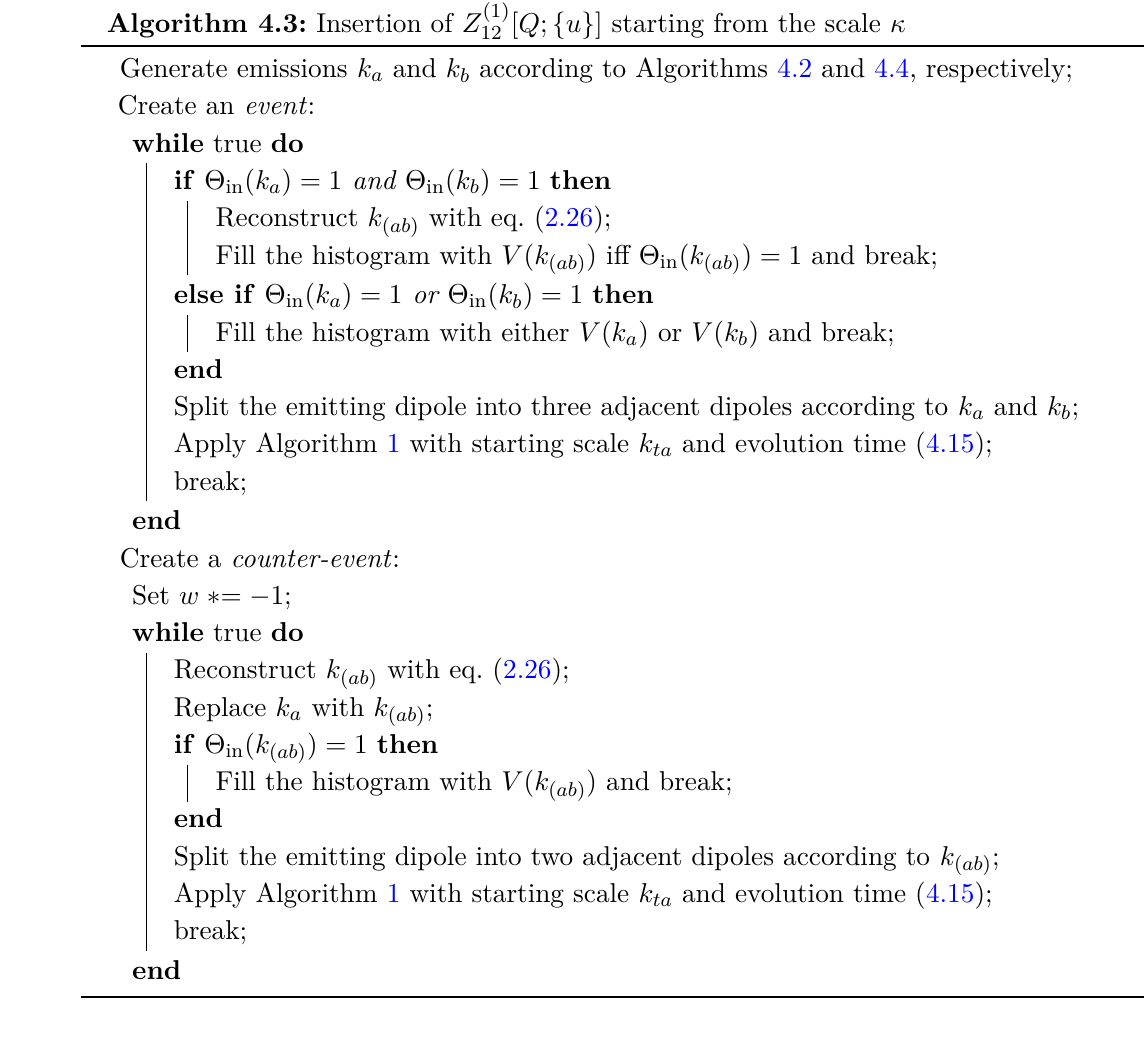
[ Q ; { u } ] starting from the scale κ 12 and k according to Algorithms 4.2 and 4.4, a b